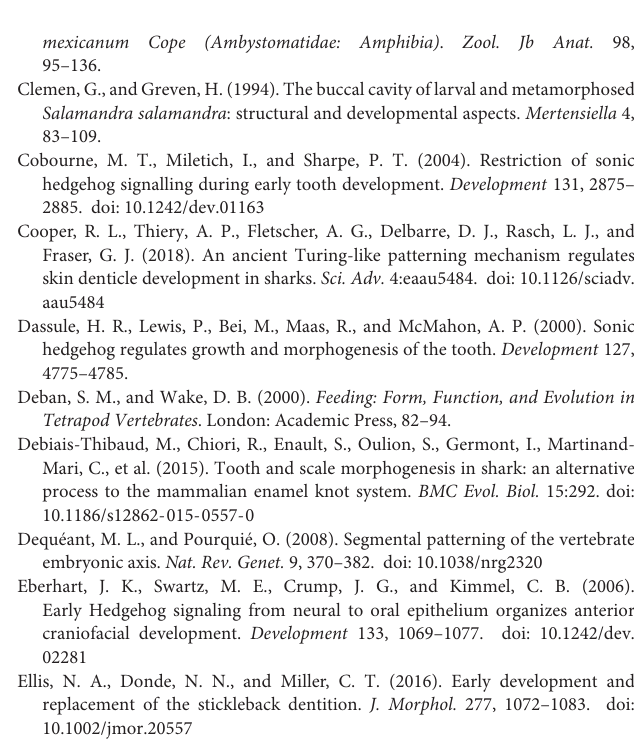
Supplementary Figure 1 | Expression of selected genes during axolotl odontogenesis. (A–D) Expression of Bmp2 and Bmp7 demarks positions of individual initiator-tooth germs of each nascent tooth field (arrows) and positions of successive tooth germs (arrowheads) in a pattern similar to that of Shh (see Figure 2 ). (E,F) Expression of Dlx3 , on the other hand, delineates positions of tooth fields (black broken lines) similarly to that of Pitx2 (see Figure 2 ). (G,H) Dlx5 transcripts are restricted to the developing tooth germs besides their presence at other craniofacial regions. cor, coronoid field; den, dentary field; pal, palatine field; pmx, premaxillary field; vom, vomerine field. Scale bar equals 500 µ m. Supplementary Figure 2 | 3D models of the developing axolotl dentition based on serial sagittal sections hybridized with the Pitx2 probe. The models visualize the shape and relationship of Pitx2 -expressing areas aka tooth competent zones and tooth fields. During embryonic development, the initially compact tooth-competent zones on the mouth roof and floor (st. 38) become compartmentalized into individual tooth fields. The models were reconstructed based on the complete series of sagittal sections hybridized with a Pitx2 probe (left column, solid lines mark the basement membrane of the oropharyngeal epithelia, broken lines mark the place of future oropharyngeal opening). Mouth roof expression is in red color, mouth floor expression in blue color, basal epithelial layer of the oral epithelium in gray color and cyan dots demark positions of tooth germs. ad, adenohypophysis; cor, coronoid field; den, dentary field; n, nasal cavity; pal, palatine field; pmx, premaxillary field; vom, vomerine field. Scale bar equals 100 µ